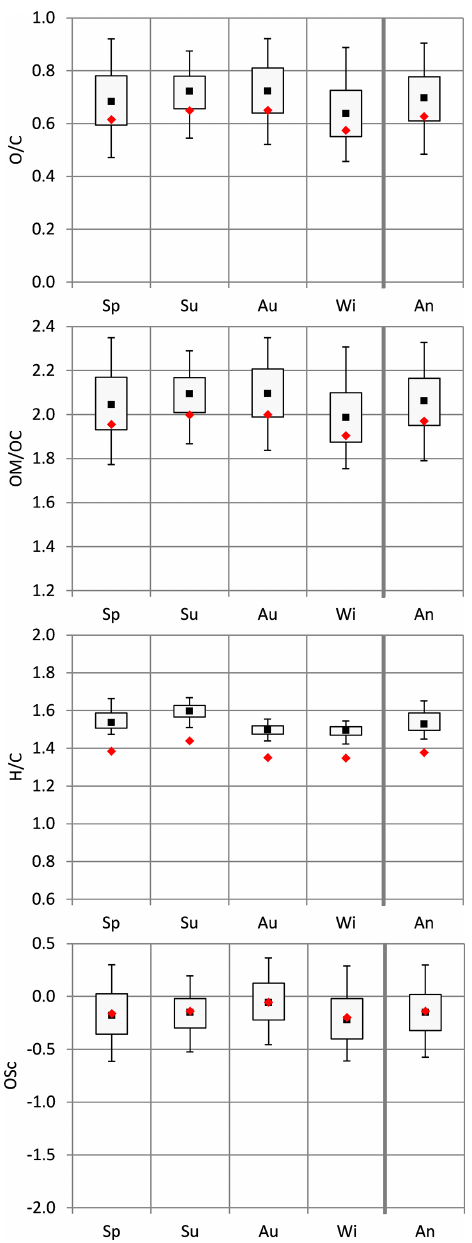
Figure 7. Seasonal and annual O / C, OM / OC, H / C and OSc of ambient OA. Sp: spring (MAM); Su: summer (JJA); Au: autumn (SON); Wi: winter (DJF); An: annual. Black: 5th, 25th, 50th, 75th and 95th percentiles estimates following Canagaratna et al. (2015); red: median estimates following Aiken et al. (2008) for O / C and OM / C, Ng et al. (2011b) for H / C, and Aiken et al. (2008), Kroll et al. (2011) and Ng et al. (2011b) for OSc. Note that the authors do not recommend comparing absolute O / C, OM / OC and OSc values reported here with other AMS studies, given the uncertain- ties associated with f 44 quantifications from ACSM measurements (please see